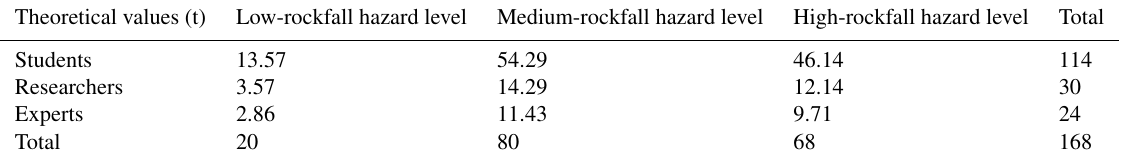
Table 11. Contingency table of the theoretical values for the chi-square test performed between the level of expertise and the level of rockfall hazard (sector 1).